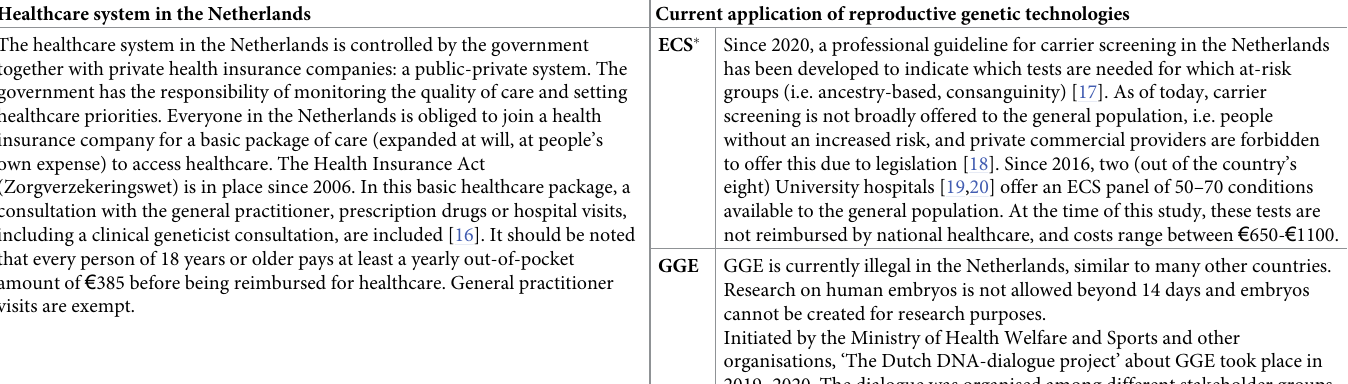
Table 1. The context of reproductive genetic technologies in the Netherlands, discussed in this